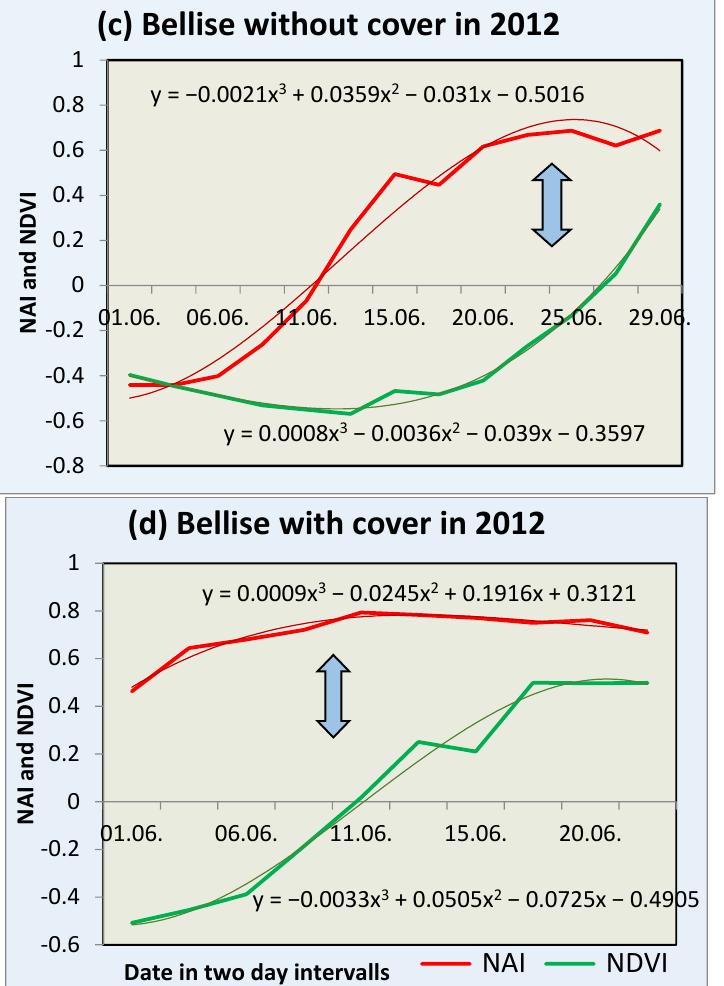
Figure 3. NAI and NDVI values in 2012 of cv. “Samba” without ( a ) and with cover ( b ) and “Bellise” without ( c ) and with cover ( d ). n = 30, polynomial function evaluate with median of the measurements; arrows show the optimum harvest (OHD).